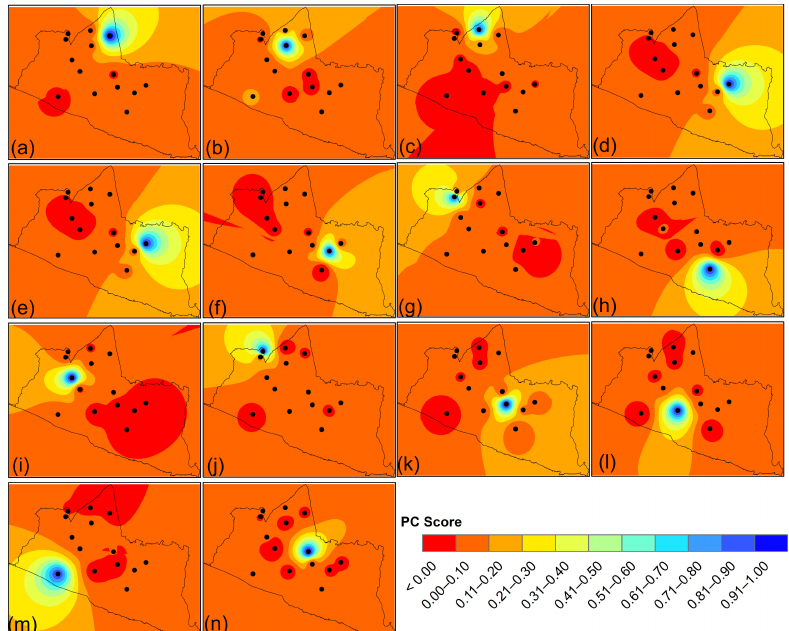
Figure 6. Spatial distribution of monthly rainfall that resulted from principal component analysis in the dry season with ( a ) PC1; ( b ) PC2; ( c ) PC3; ( d ) PC4; ( e ) PC5; ( f ) PC6; ( g ) PC7; ( h ) PC8; ( i ) PC9; ( j ) PC 10; ( k ) PC11; ( l ) PC12; ( m ) PC13; ( n ) PC14